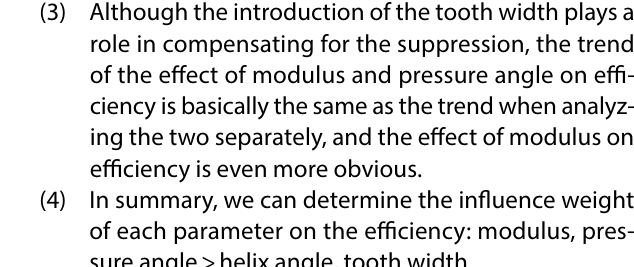
Fig. 19 Efficiency of different modulus and helix angle at equal bending strength of the teeth and pressure angle of 20°